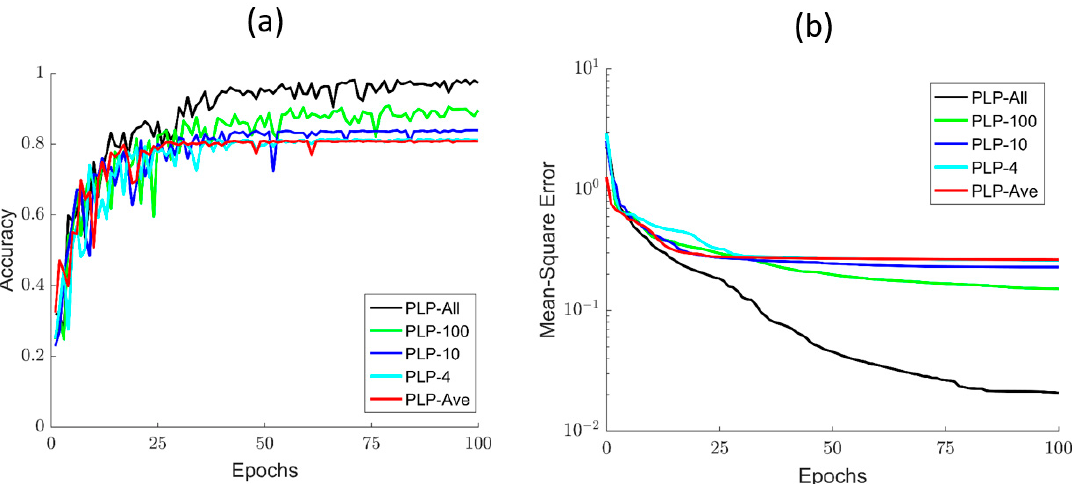
Figure 6. ( a ) The accuracy curve of different processing methods; ( b ) the MSE of different processing methods.